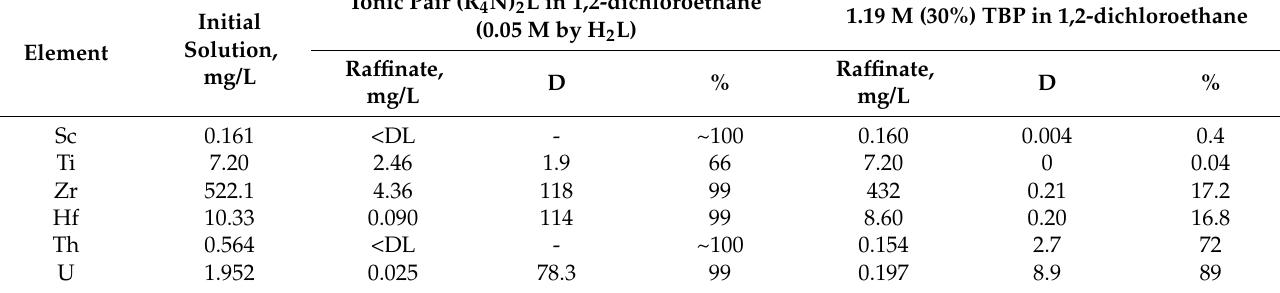
Table 8. Comparison of the extraction ability of the (R 4 N) 2 L ionic pair with 30 vol.% TBP in